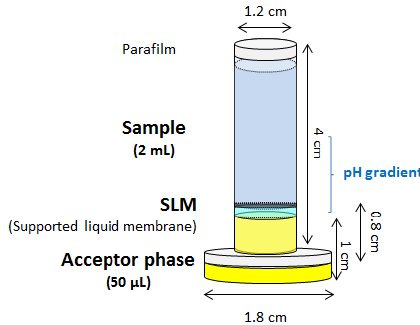
Figure 6. Modification of the stir membrane liquid-liquid-liquid extraction device to process a low volume of sample. SLM, supported liquid membrane.